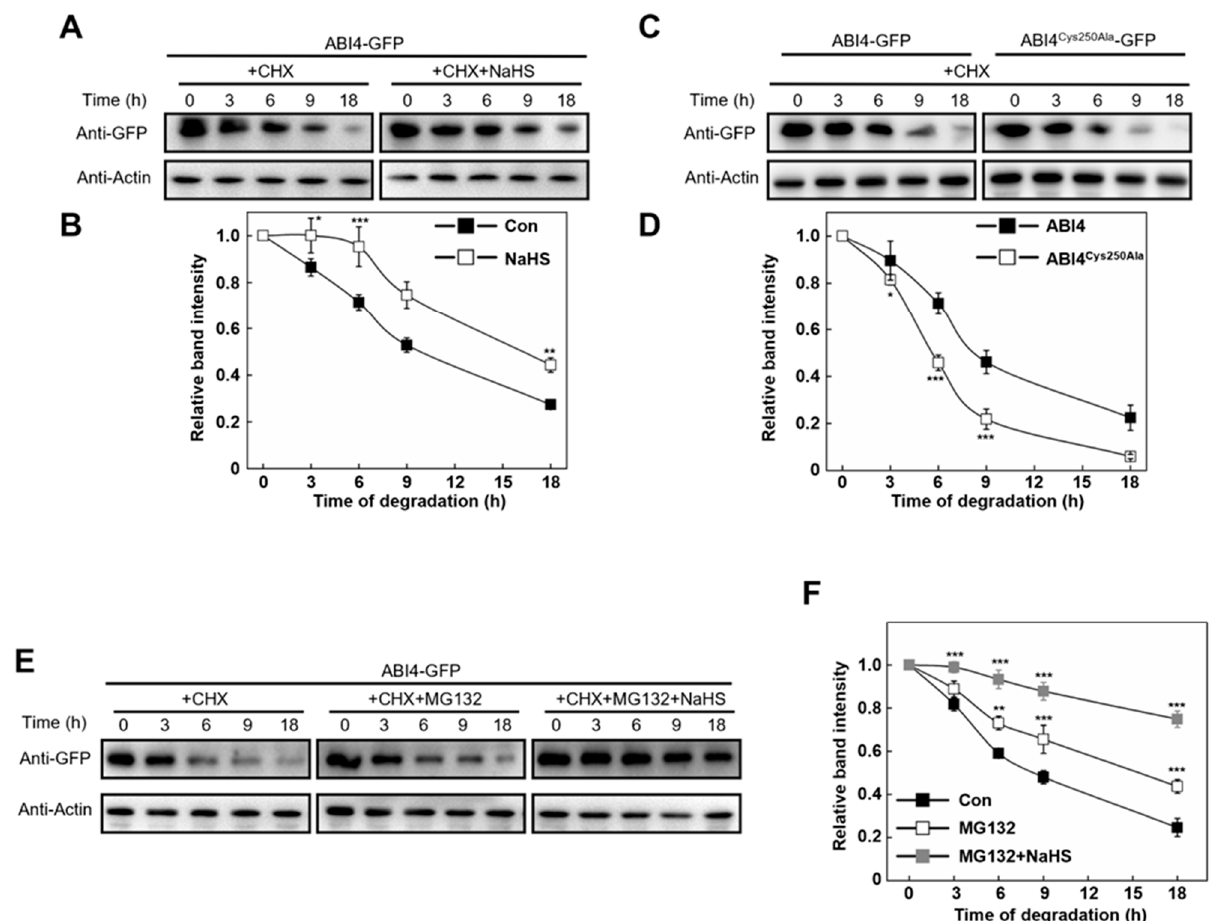
Figure 5. The stability of ABI4 is regulated by its persulfidation In vivo. ( A ) The effect of NaHS on the stability of ABI4 In vivo. Arabidopsis protoplasts isolated from the Col-0 lines were transfected with ABI4-GFP expressing plasmid constructs. After incubation in low light for 12 h, protoplasts were treated with 0.1 mM NaHS (or distilled water, as a control) and 150 µM CHX (to block protein translation) for 1 h. Then protoplasts were lysed and incubated at 30 ° C after being divided into five tubes. Samples were stopped at indicated time points and checked by immunoblot analysis. Proteins